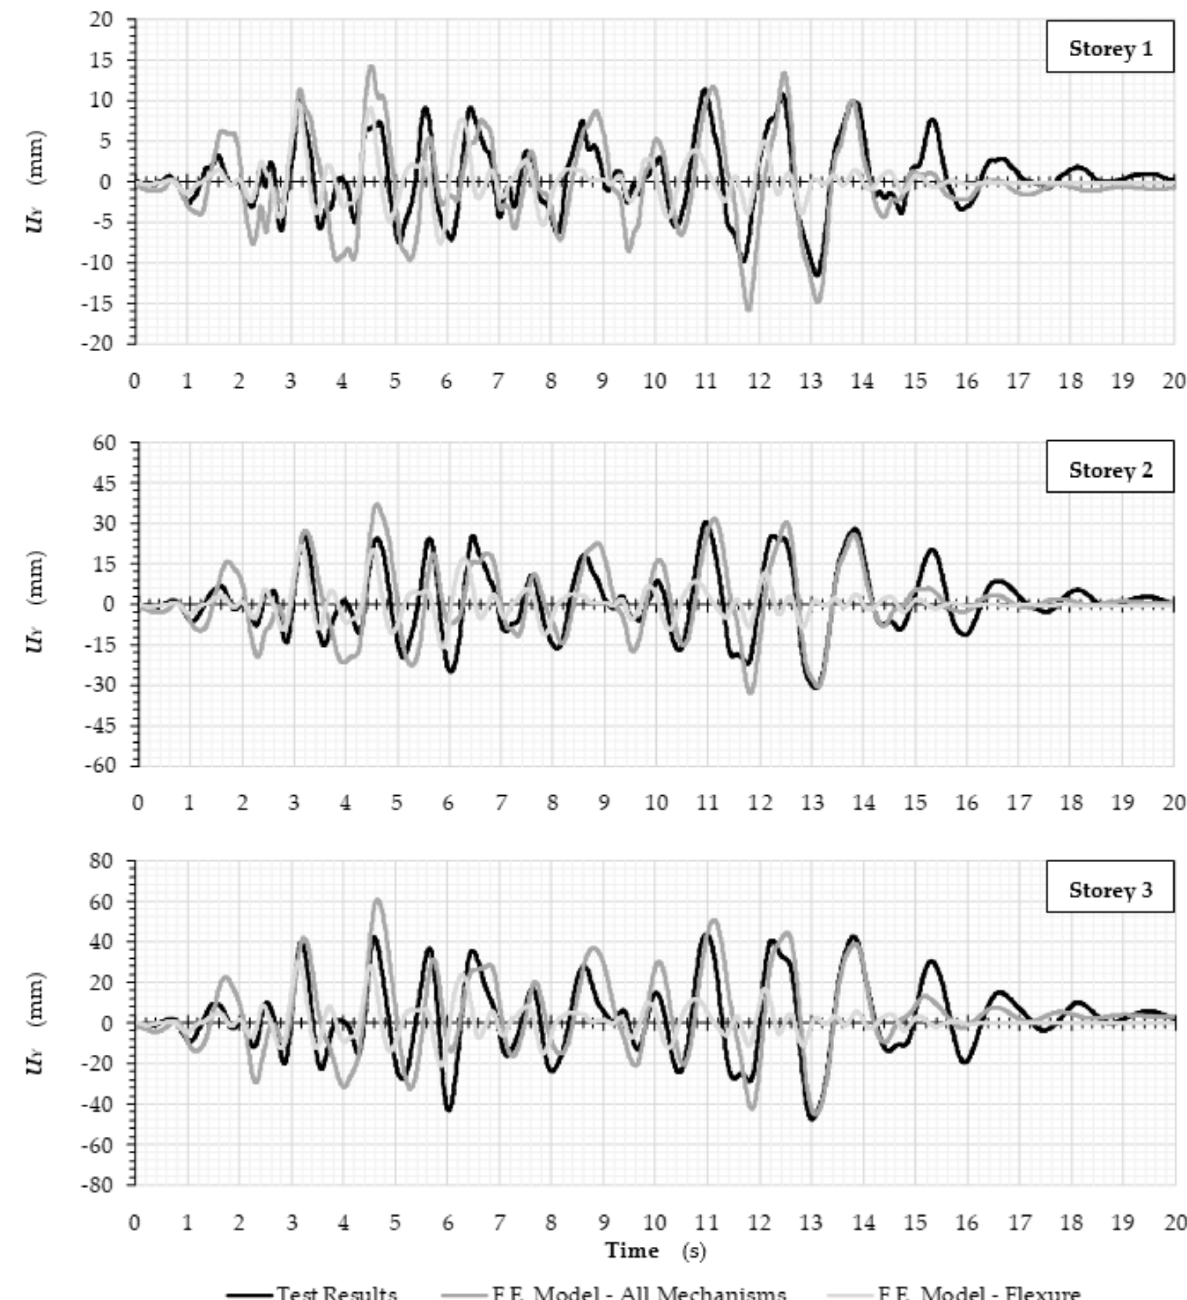
Figure 11. Comparison of the horizontal displacements in the Y -plan direction measured at the SPEAR building during the s11 earthquake case and the corresponding response estimated from a dynamic analysis using two different FE building